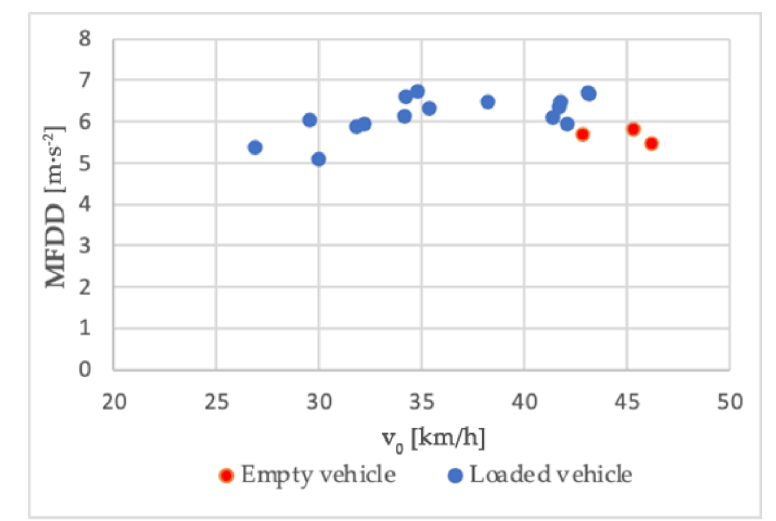
Figure 15. A comparison of mean fully developed deceleration (MFDD) in the case of a loaded and an empty